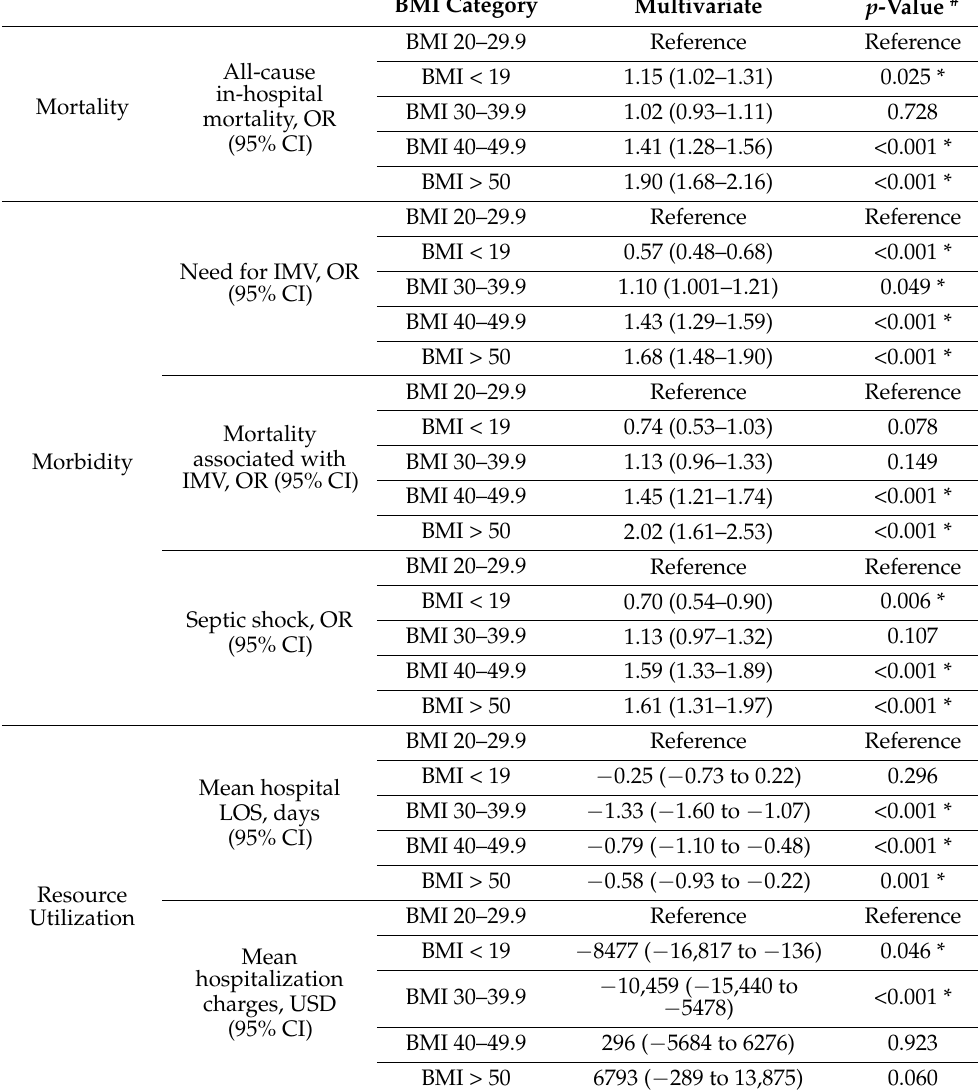
Table 5. Regression outcomes of comparing the body mass index categories to body mass index 20–29.9 as a